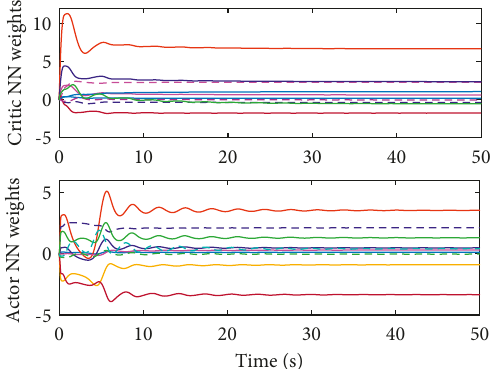
Figure 4: Profiles of critic-actor NN weights [18].